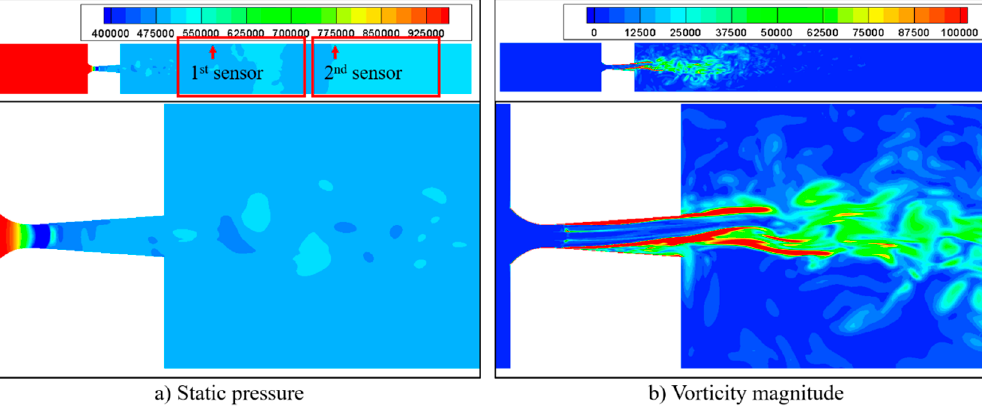
Figure 11. Unsteady Large Eddy Simulation (LES) results; ( a ) static pressure (Pa); ( b ) vorticity